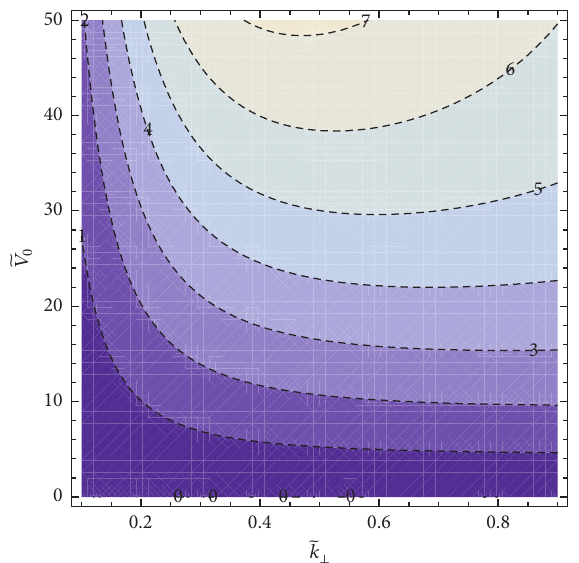
̃𝑘 𝑉 𝐶 = 10 , 𝑍 ⊥ and 0 for 𝑄